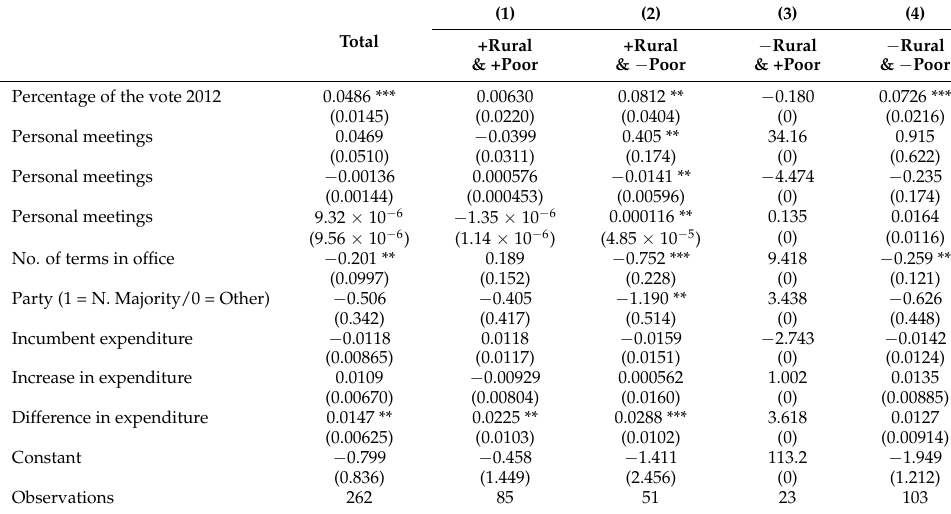
Table 3. Predictors of mayors’ re-election